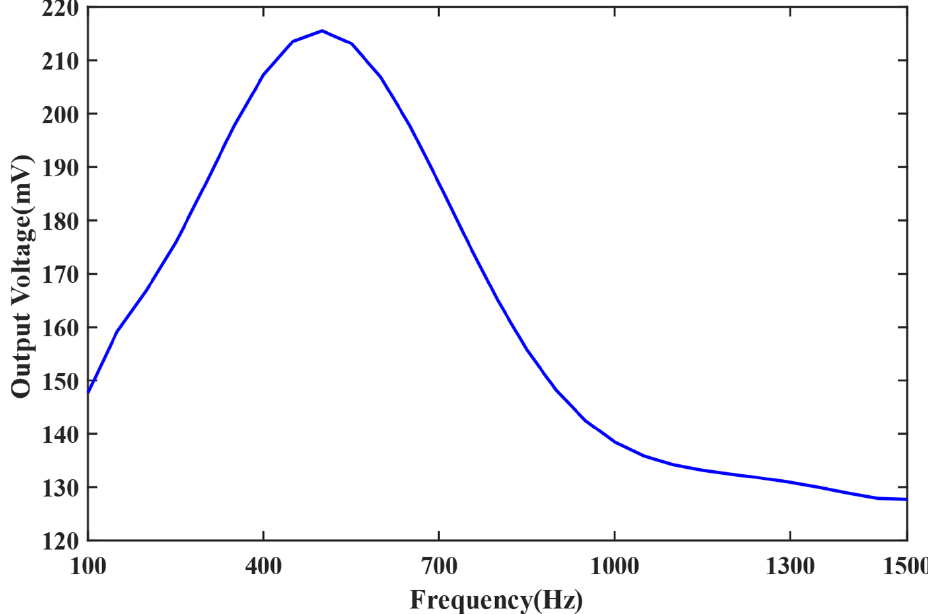
Figure 9. The sound frequency spectral between 100 and 1500 Hz.